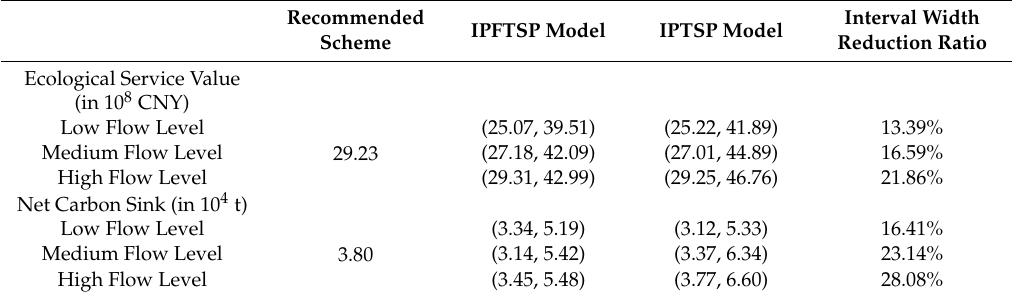
Table 7. Ecological service value and net carbon sink generated by the ecological function regions recovered through multiple water supplement schemes under di ff erent flood flow